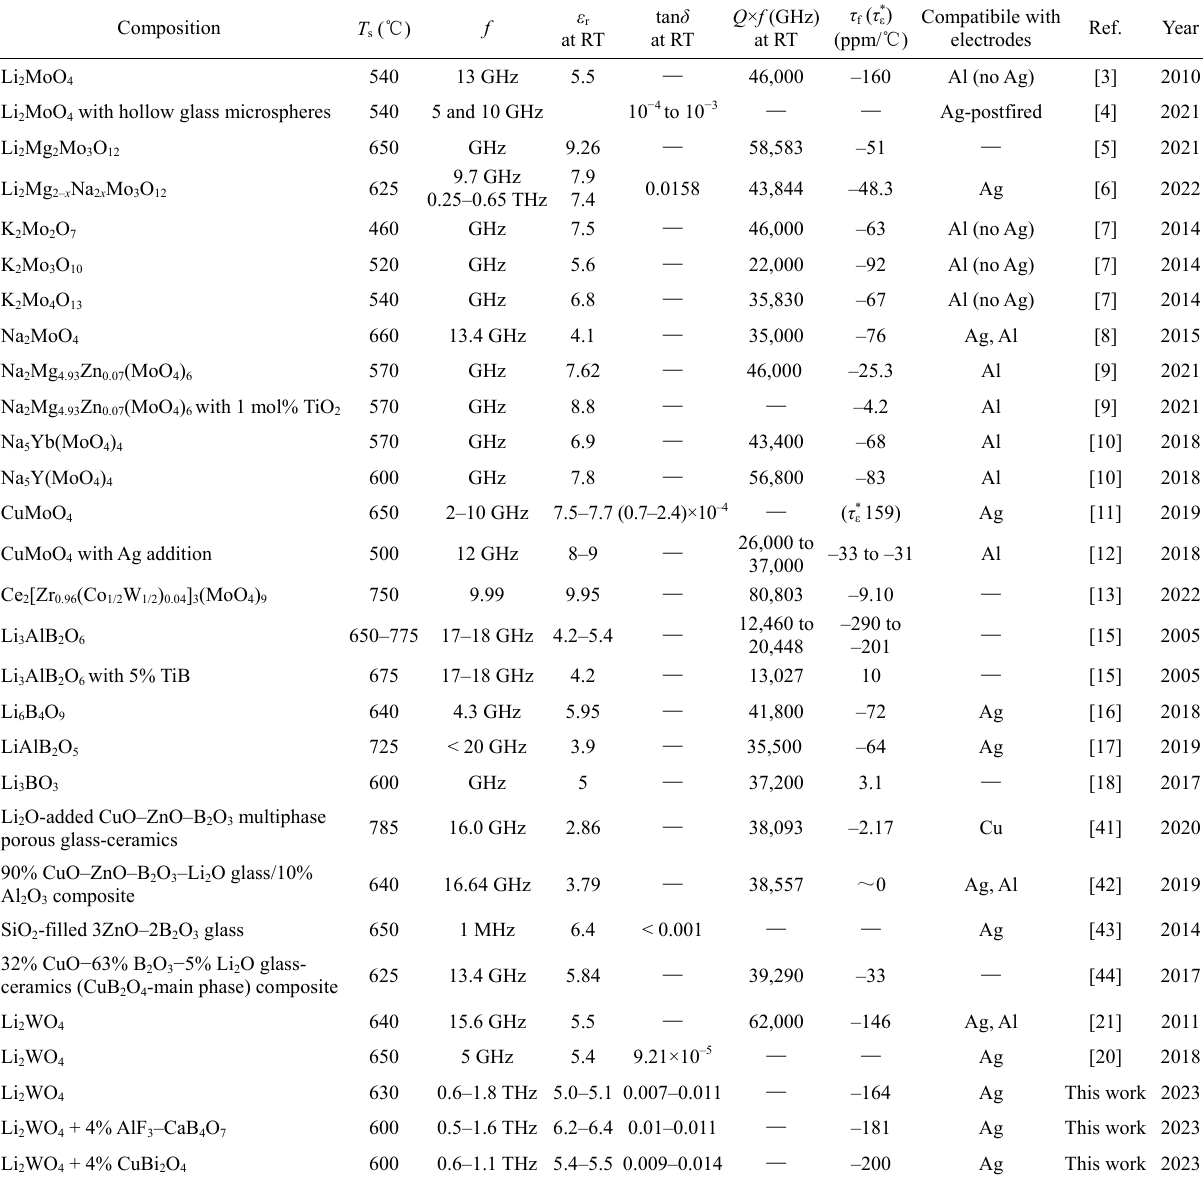
Table 2 Sintering temperatures ( T s ) and dielectric properties of ULTCC materials with low dielectric permittivities ( ε r < 10) at frequencies ( f ) in GHz and THz ranges